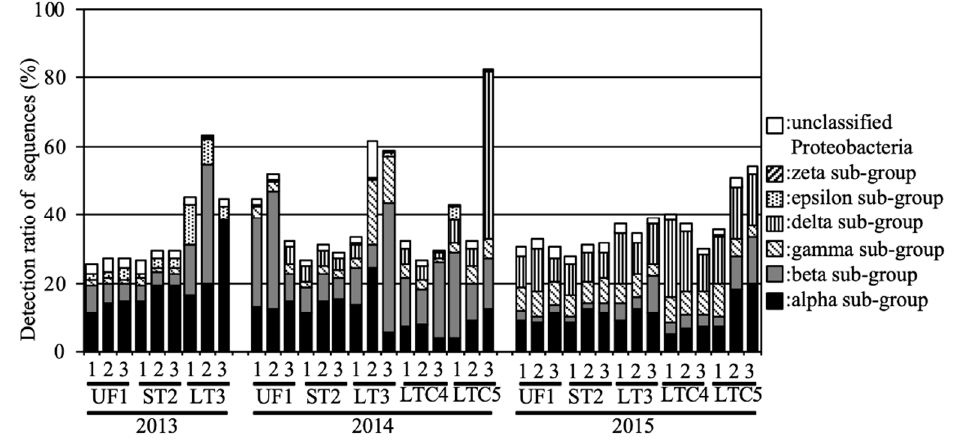
Figure 3. Relative abundances of the Proteobacteria subgroups in the soil samples.